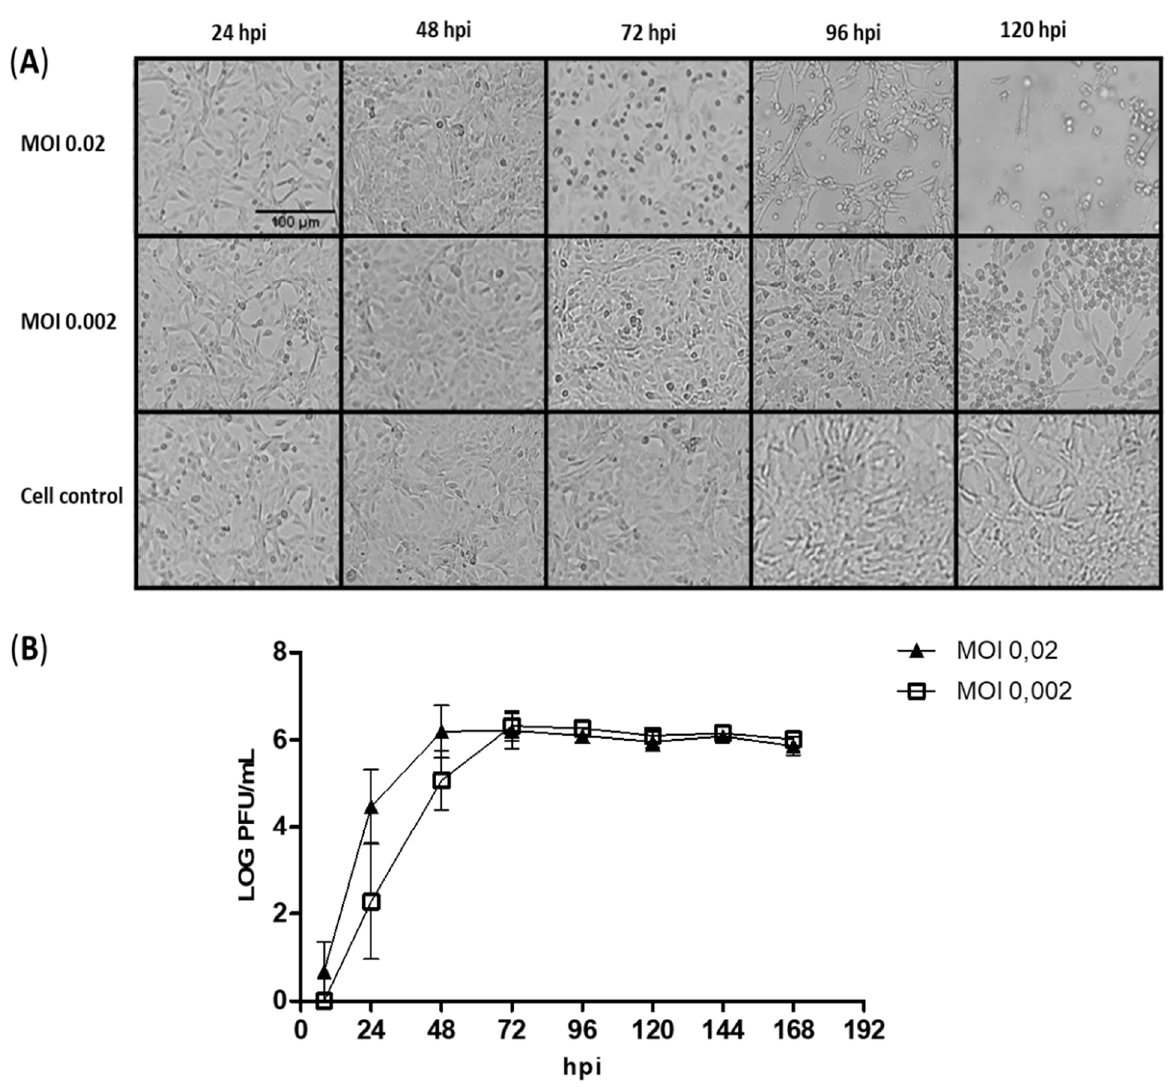
Figure 1. Viral kinetics of ES 2916/2015 Zika virus (ZIKV) in VERO cells at MOI 0.02 and MOI 0.002. ( A ) Cell monolayer images demonstrating the cytopathic effect of ZIKV over time. ( B ) Viral titers determined by plaque-forming unit (PFU) assay.